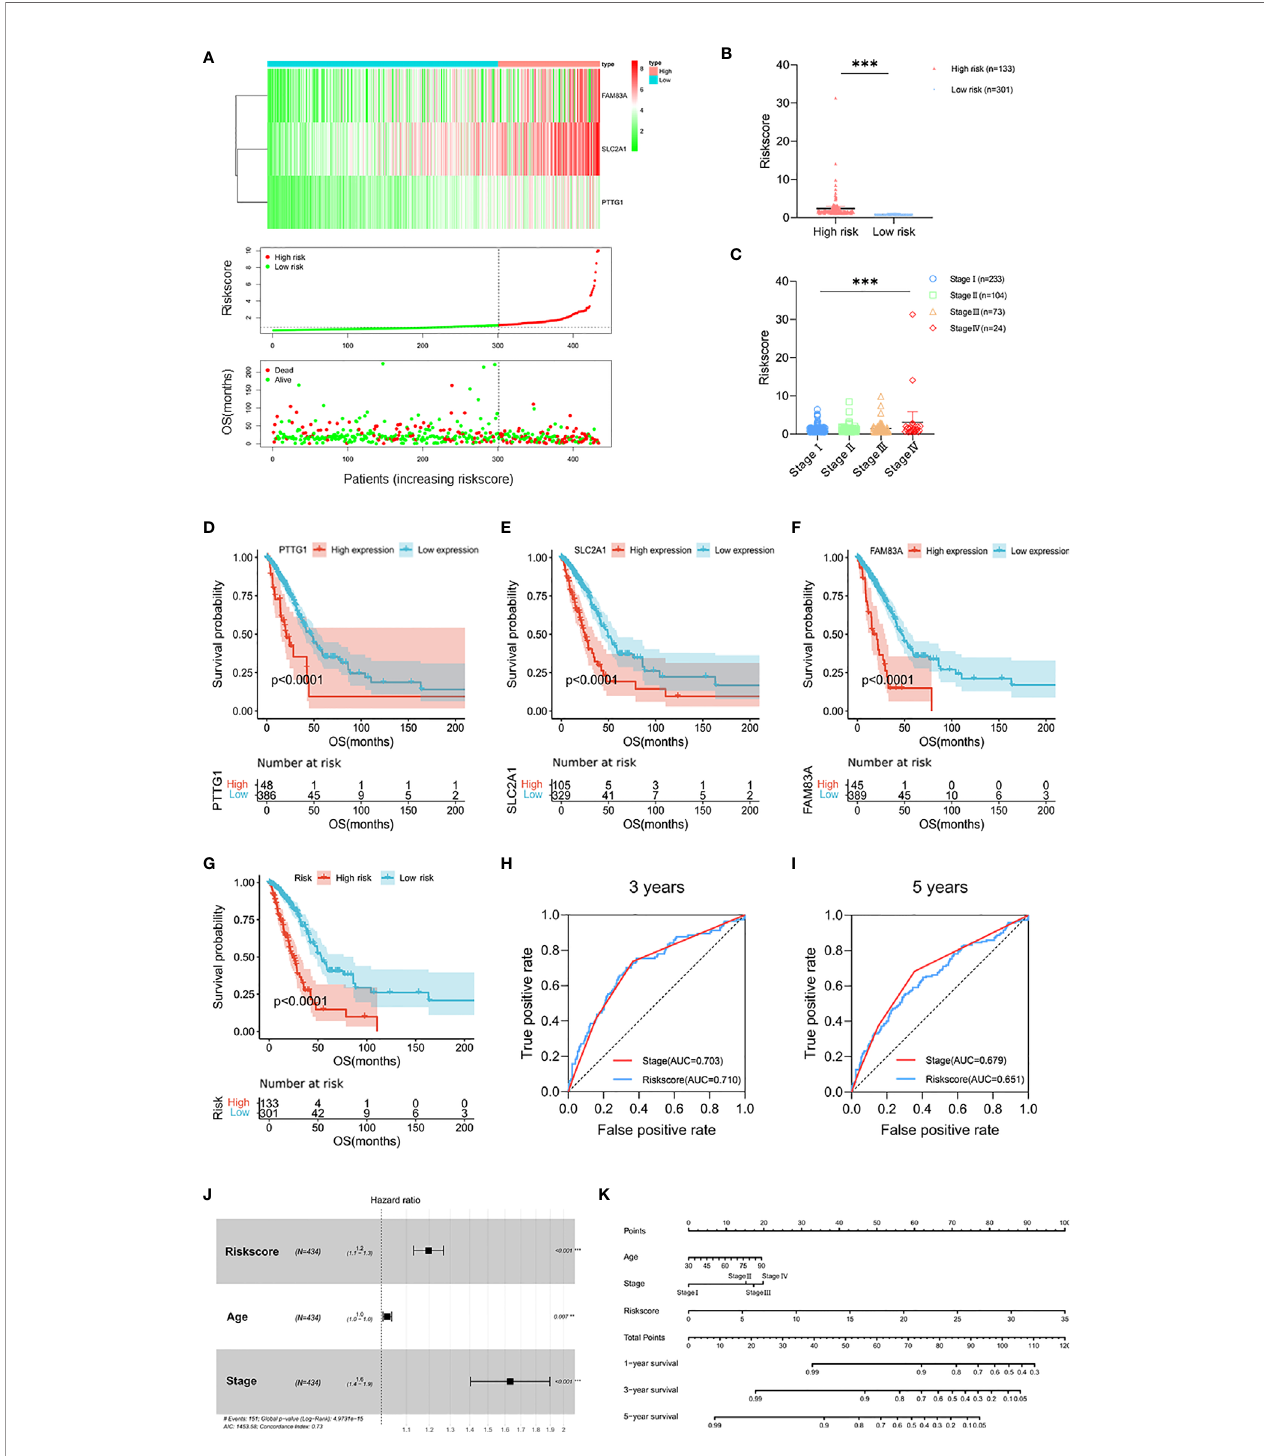
FIGURE 3 | Prognostic risk model built by PTTG1 , SLC2A1 , and FAM83A . (A) Heat map of PTTG1 , SLC2A1 , and FAM83A in the TCGA cohort (upper fi gure). Distribution of risk score (middle fi gure), and OS (lower fi gure). (B) The risk score in the high-risk group (n = 133) and low risk group (n = 301). (C) Distribution of risk scores classi fi ed by stage. (D, G) Kaplan – Meier curves for OS by expression of (D) PTTG1 , (E) SLC2A1 , (F) FAM83A , and (G) risk subgroups in the TCGA cohort. Signi fi cance was determined using the log-rank p test. (H, I) Time-dependent ROC curves measuring the predictive value of the risk score and stage at (H) 3 years and (I) 5 years in the TCGA cohort. (J) Forest plot showing the independent prognostic factors for OS in the TCGA cohort (multivariate Cox regression analysis). (K) Nomogram for predicting 1-, 3-, and 5-year overall survival in the TCGA cohort. Mean with 95% CI; **p < 0.01, and ***p <